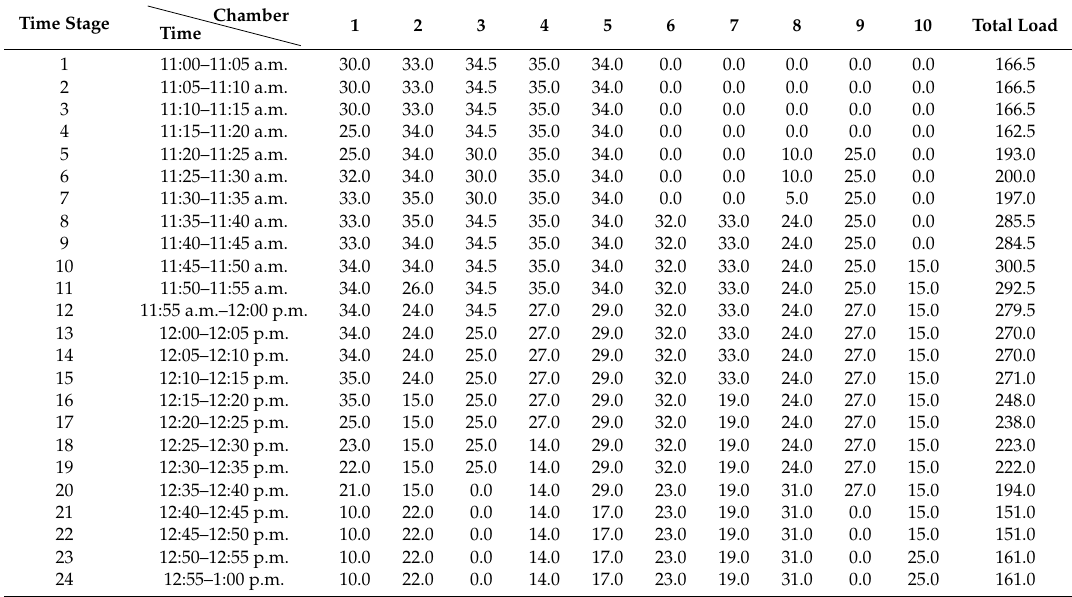
Table 2. The load change of refrigerating chamber (kW).